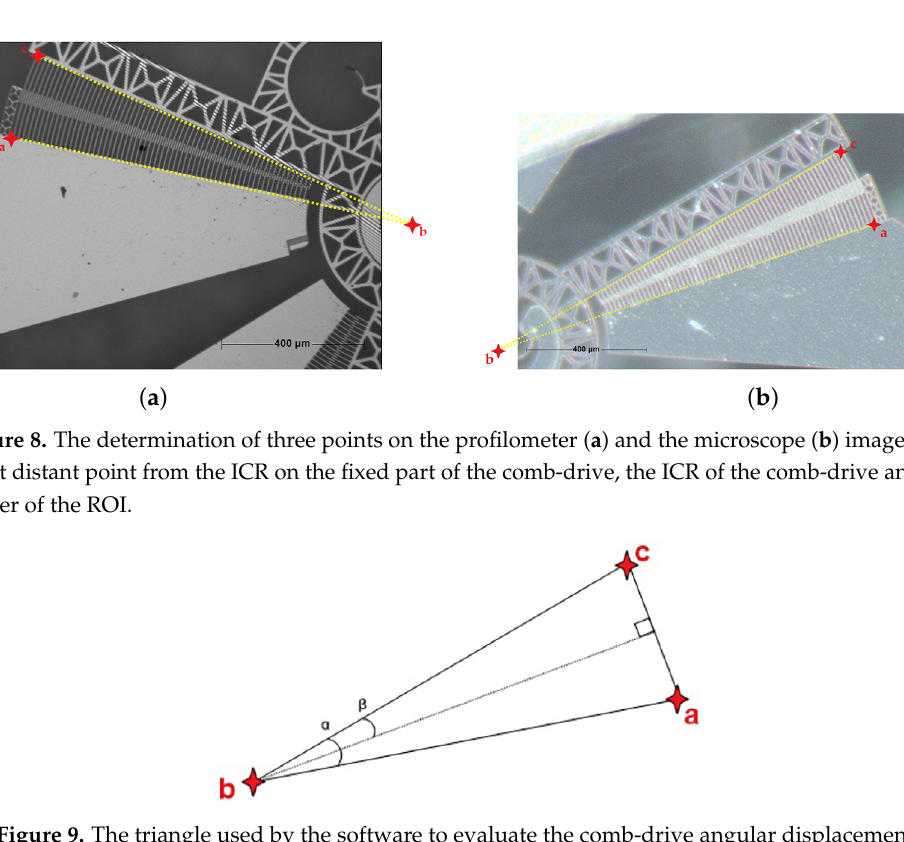
Figure 9. The triangle used by the software to evaluate the comb-drive angular